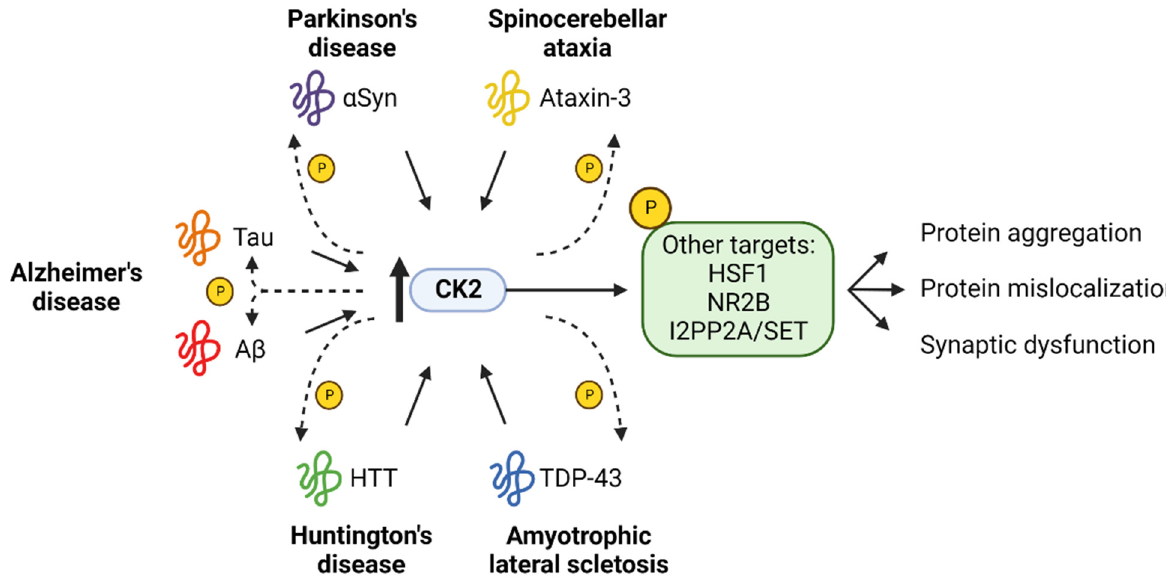
Figure 4. Activation of CK2 at the center of multiple neurodegenerative diseases. Upregulation of CK2 may serve as a convergent mechanism of neurodegeneration across several neurodegenerative disorders. CK2 mediates phosphorylation of the main pathological proteins for each of those dis- eases and further phosphorylates additional substrates. This working model proposes CK2-medi- ated phosphorylation of different targets influence disease pathology through mechanisms such as protein aggregation, protein mislocalization, and influencing synaptic dysfunction. Created with BioRender.com (accessed 10 August 2022).